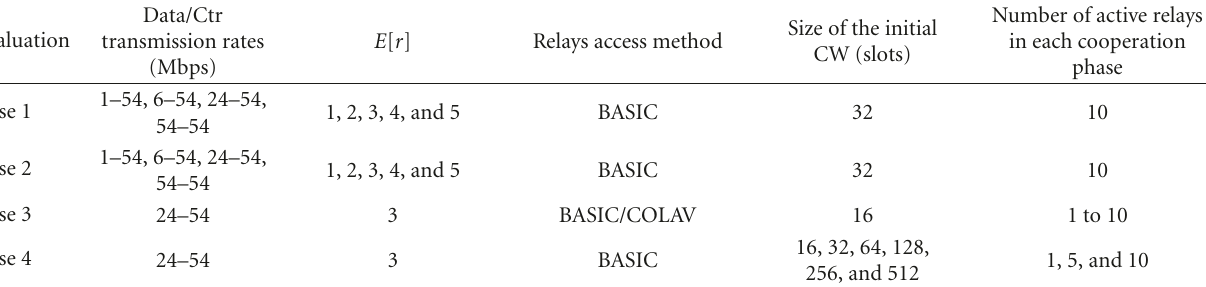
Table 3: Simulation parameters for each evaluation